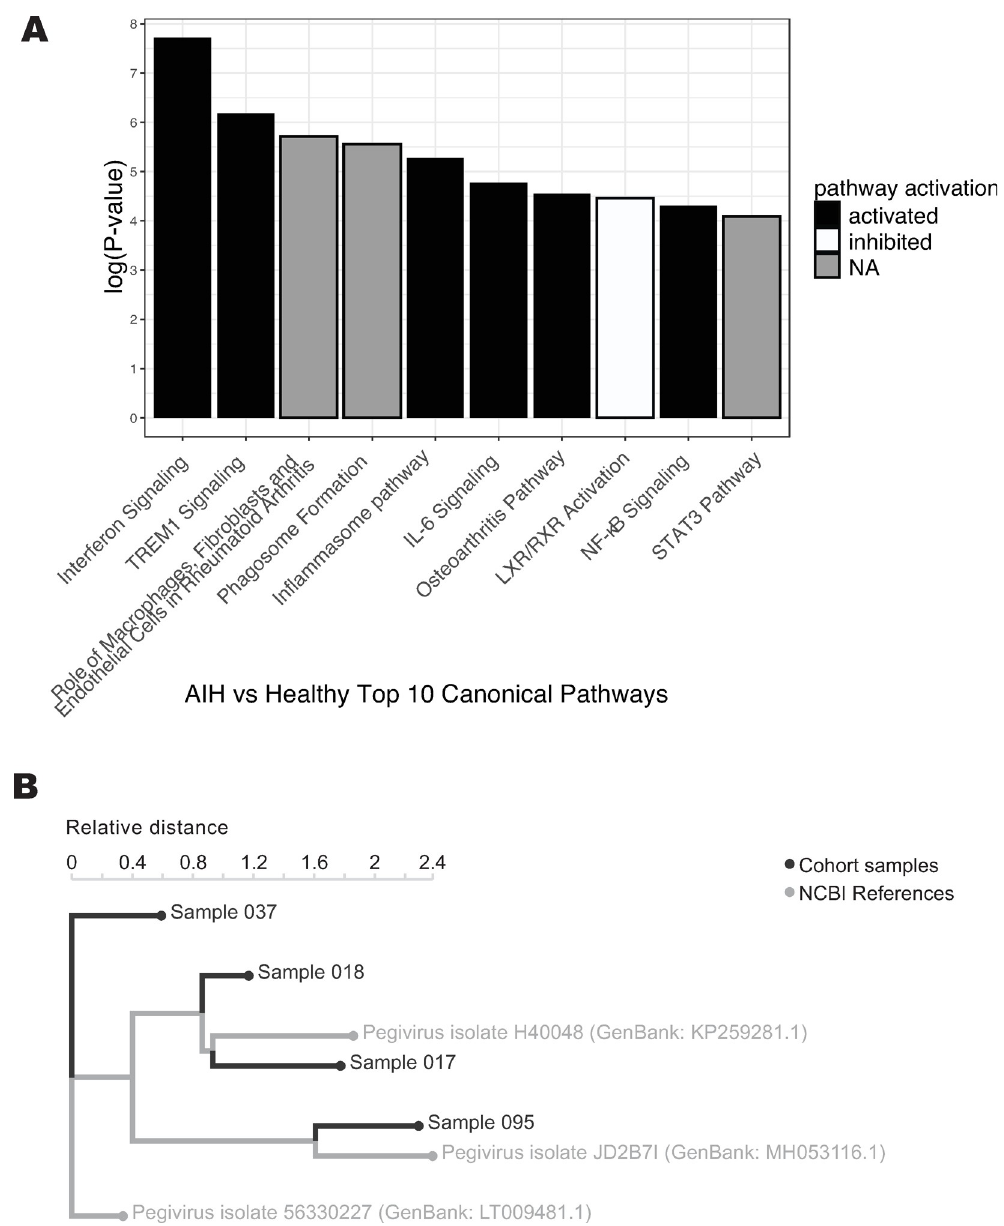
Fig 2. A. Top ten most significant canonical pathways related to differential gene expression of AIH patients compared to healthy controls. B. kmer-based phylogenetic analysis performed with the IDSeq platform shows relationships between four assembled pegivirus genomes from the GRACE cohort and their closest related publicly available pegivirus NCBI reference genomes, with patient metadata